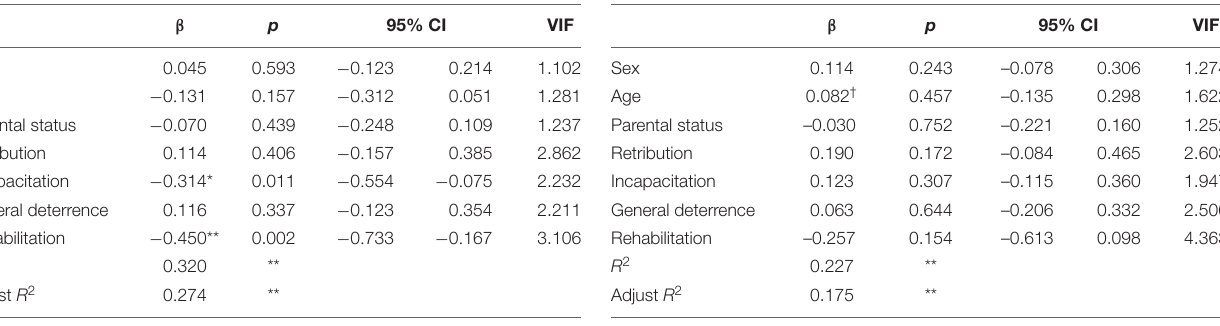
TABLE 2 | Regression analysis (severe-damage scenario). TABLE 3 | Regression analysis (moderate-damage